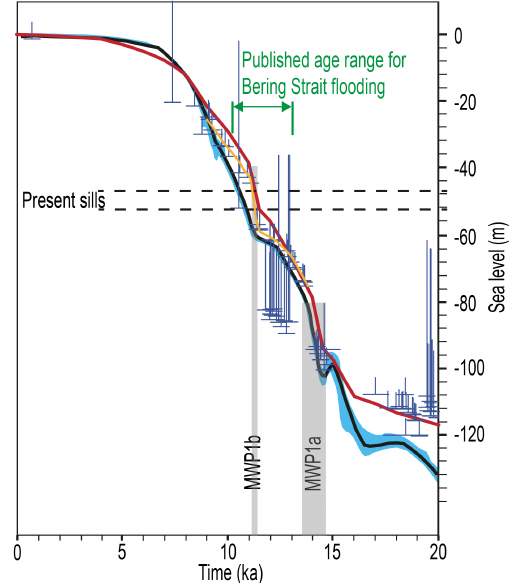
Figure 2. Different estimations of eustatic sea level change over the last 20000 years. The black curve shows the ice-volume-equivalent sea level change along with its 95% probability limit in blue by Lambeck et al. (2014). The blue bars show sea level estimations using the coral reef record at Barbados, and the red line is the pre- diction of the sea level history using the ICE-5G (VM2) model at the same site (Peltier and Fairbanks, 2006). The orange line is the most recent reconstruction using the Barbados coral reefs by Abdul et al. (2016). The time intervals of meltwater pulse 1a (MWP1a) and meltwater pulse 1b (MWP1b) are indicated by the gray bars. The depths of the present sills in the Bering Strait area (see Fig. 1) are shown by black stippled